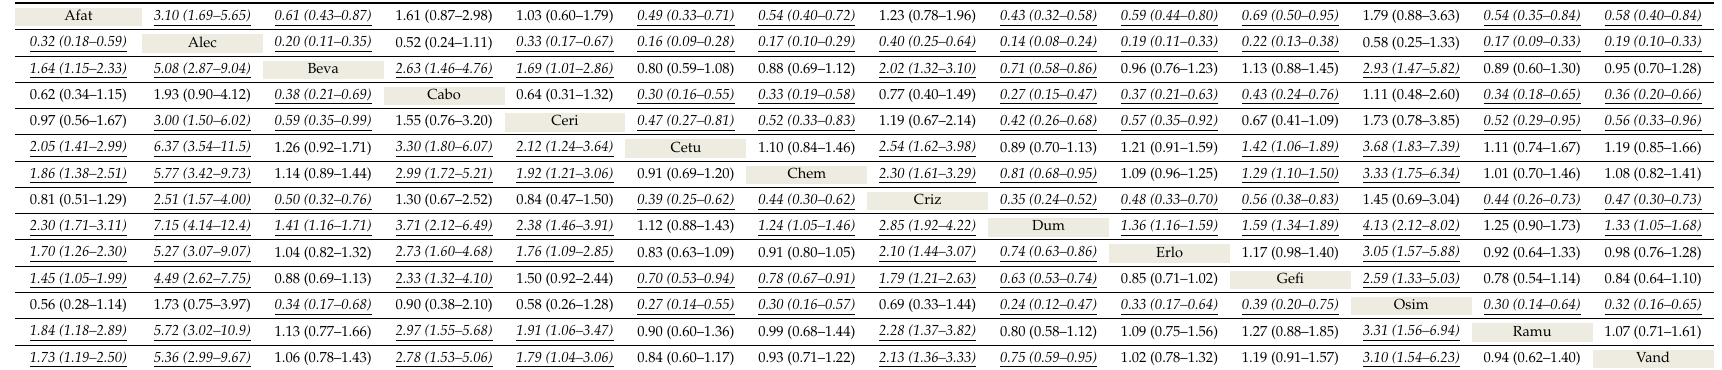
Drugs are reported in alphabetical order. Data in the right-upper triangle are HRs (95% CI) in the row-defining treatment compared with the column-defining treatment. HRs lower than 1 favour the row-defining treatment (the first drug in alphabetical order). HRs for the opposite comparison of PFS are in the left-lower triangle. Each comparison is shown twice in the table, once with drug A vs. drug B and once with drug B vs. drug A. Significant results are in italic and underscored. HR, hazard ratio; CI, confidence interval; PFS: progression-free survival. Afat, afatinib; Alec, alectinib;. Beva, bevacizumab; Cabo, cabozantinib; Ceri, ceritinib; Cetu, cetuximab; Chem, chemotherapy;. Criz, crizotinib; Dum, dummy; Erlo, erlotinib; Gefi, gefitinib; Osim, osimertinib; Ramu, ramucirumab; Vand,